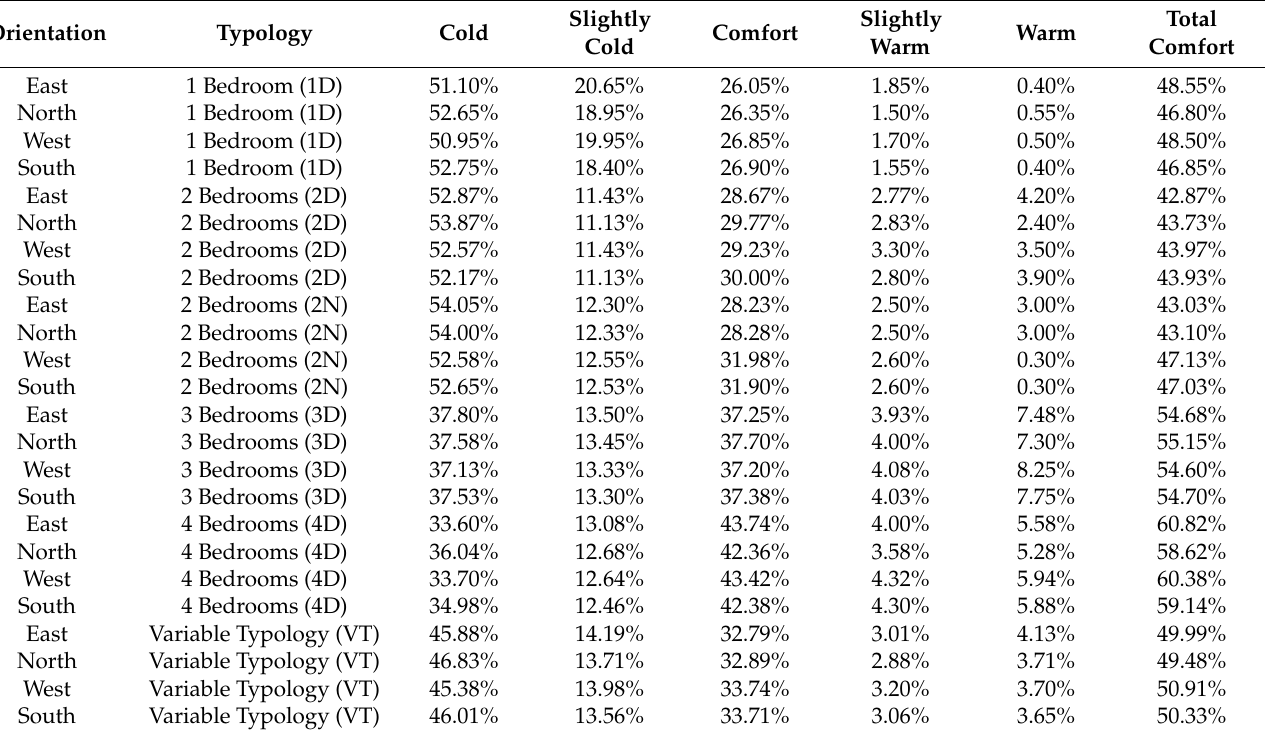
Table A7. Percentage of time in different thermal situations for the spaces in each type of home.